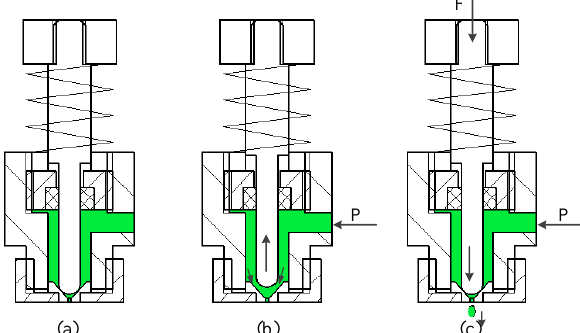
Figure 2. Jetting principle. ( a ) Normal state; ( b ) needle upward movement; ( c ) needle downward movement.